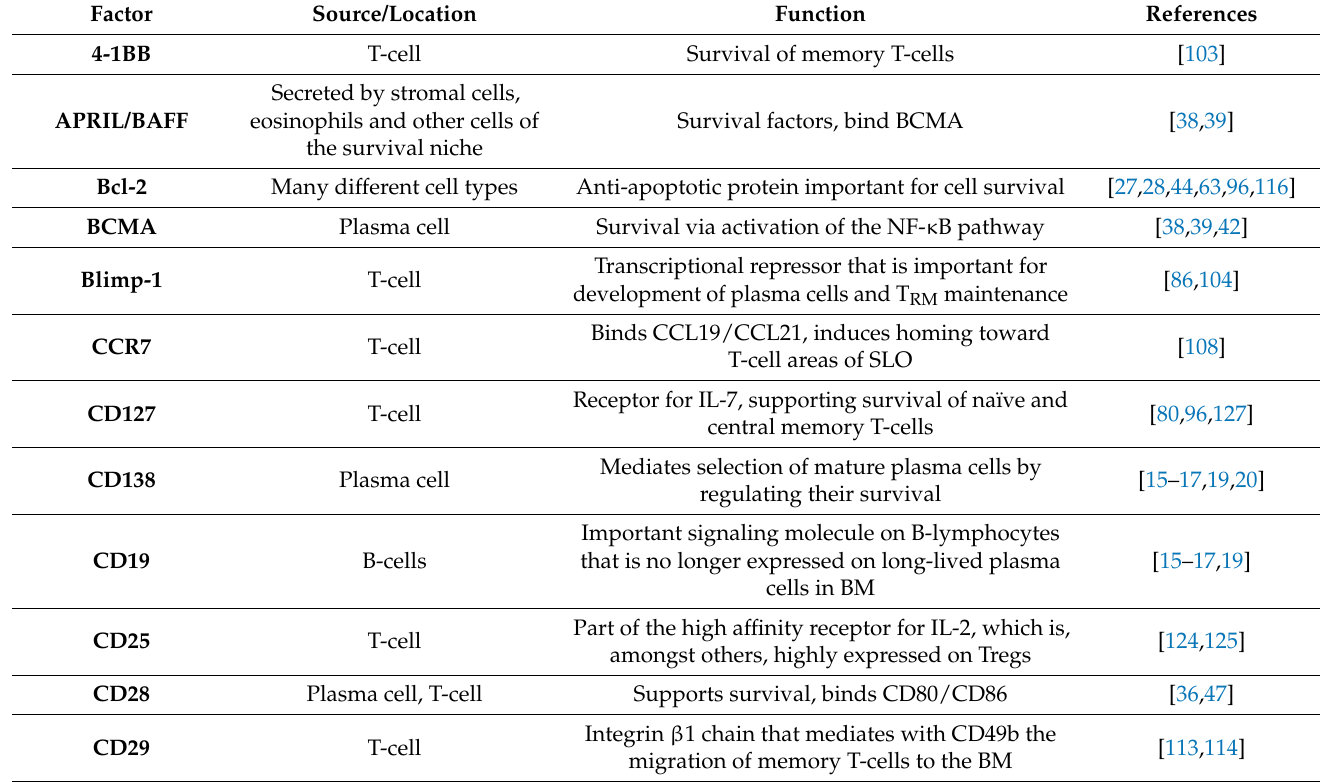
Table 1. List of molecular factors relevant for the immune function of the